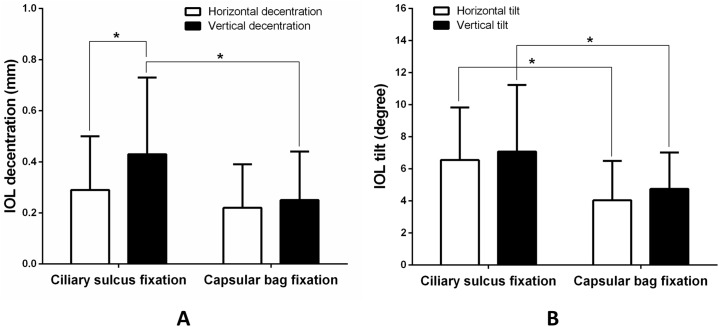
Comparison of intraocular lens (IOL) decentration (A) and IOL tilt (B) between the ciliary sulcus fixation and capsular bag fixation groups in horizontal and vertical directions. (* indicates significant difference groups, p < 0.05)